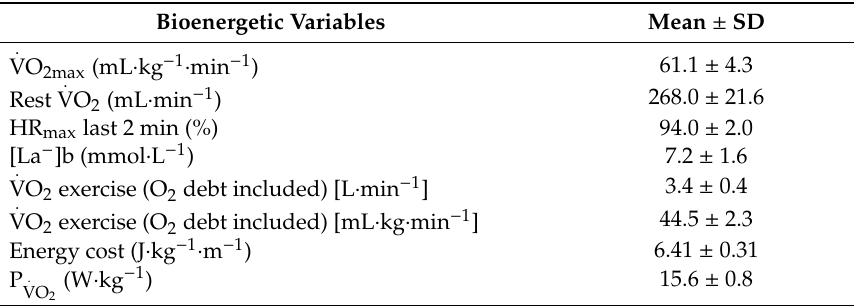
Table 4. Physiological and metabolic responses to the soccer-specific circuit.